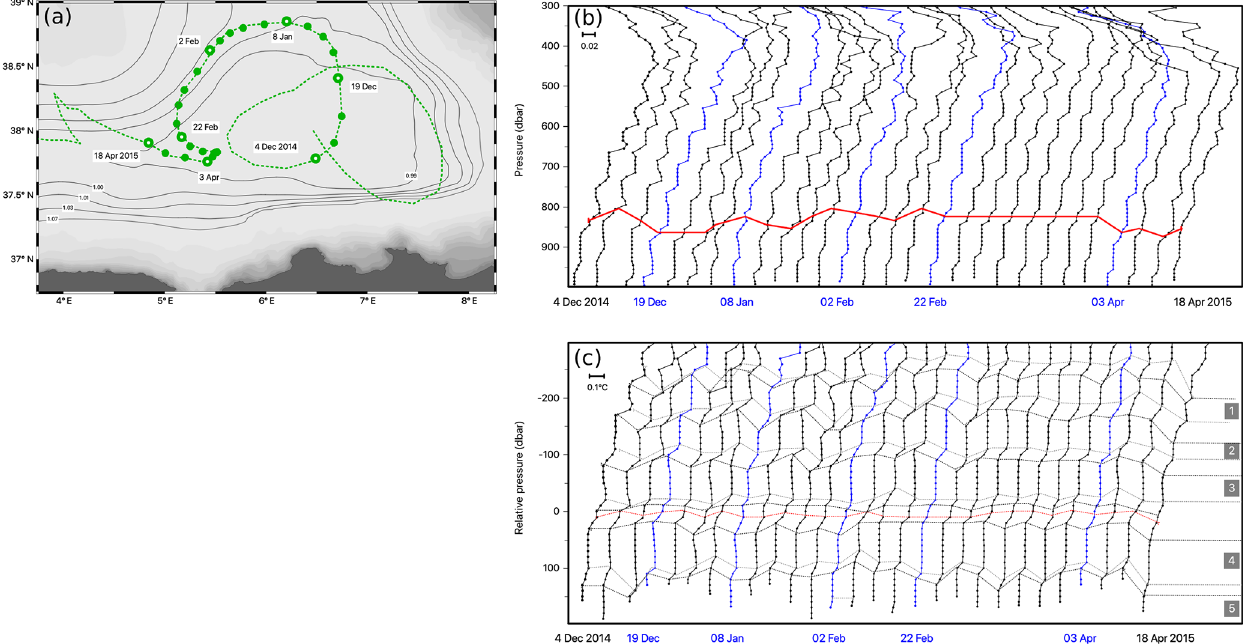
Figure 11. Drift trajectory (a) and successive profiles of temperature (b) and salinity (c) collected by float 6901600 between 4 December 2014 and 18 April 2015, with a vertical resolution of 10dbar. Temperature profiles are shifted by 0.1 ◦ C, salinity profiles by 0.02. Values on the y axis correspond to the pressure referenced to the surface (b) or to the relative pressure referenced to the interface 3/4 indicated by the red line (c)